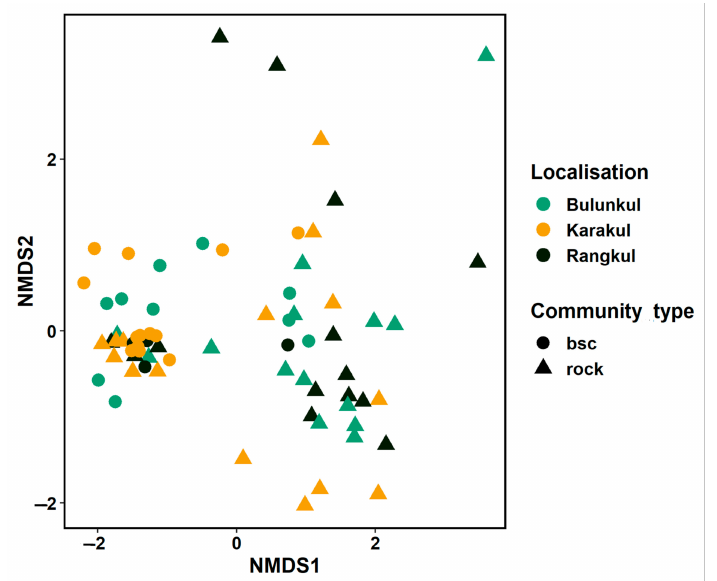
Figure 3. Comparison of the structure of endolithic and soil-inhabiting communities. NMDS (non- metric multidimensional scaling) using the amplicon sequence variant (ASV)-based structure of investigated communities and using the Bray–Curtis dissimilarity